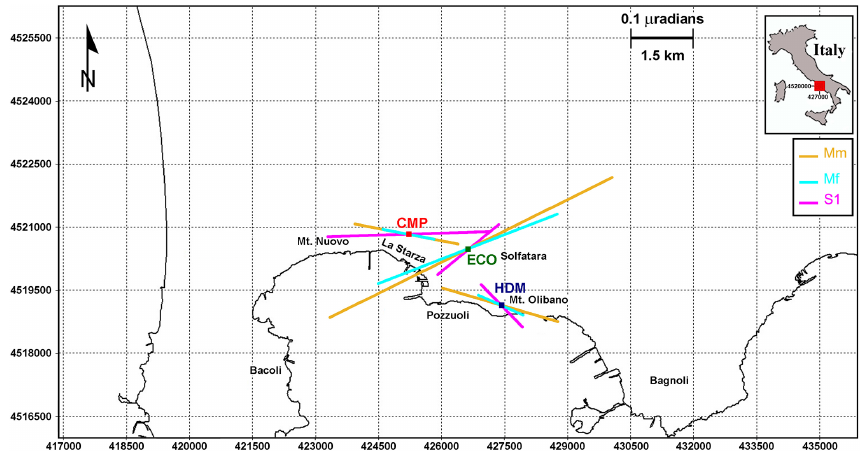
Figure 5. Map of the Campi Flegrei caldera, superimposed on a grid representing the two-dimensional plane of the ground inclinations. For each station, the predominant directions along which the ground tilts with monthly (ochre), fortnightly (cyan) and diurnal (magenta) period are represented (after De Lauro et al., 2018).